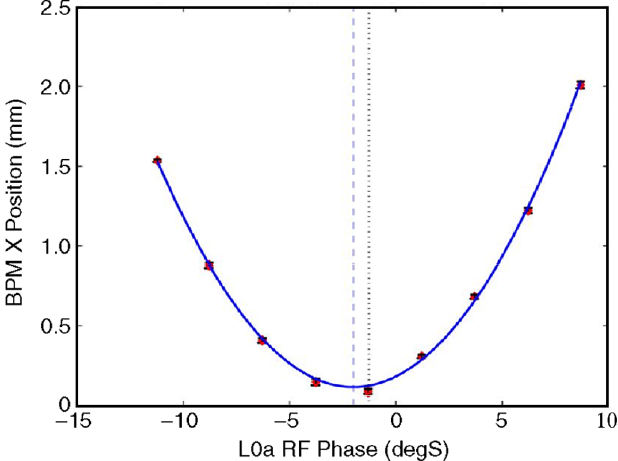
FIG. 19. (Color) An L0a rf phase scan used to find the rf crest phase by measuring beam position on a BPM after a bend magnet. The typical phasing resolution using 5 shots per phase setting and a parabolic fit is < 0 : 1 (cid:9)